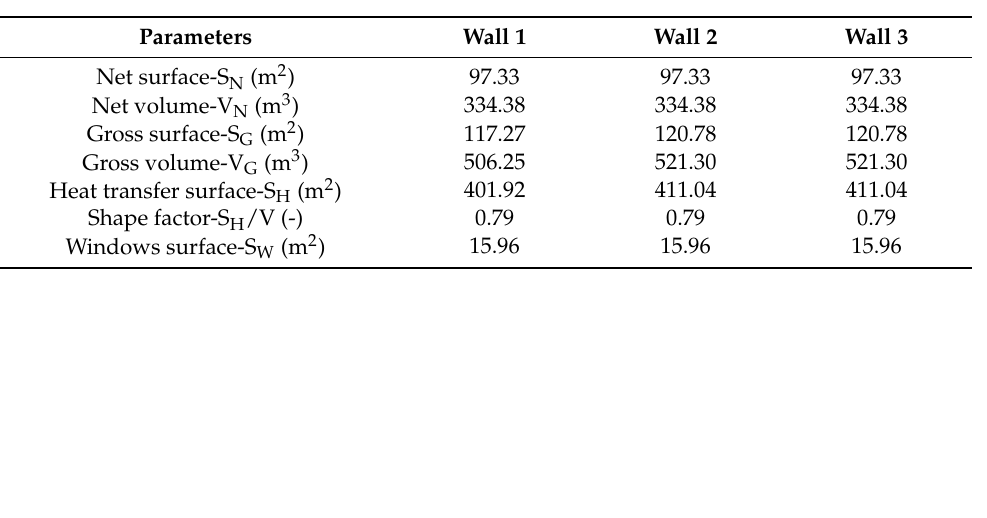
Table 6. Case study: geometric characterization of the detached